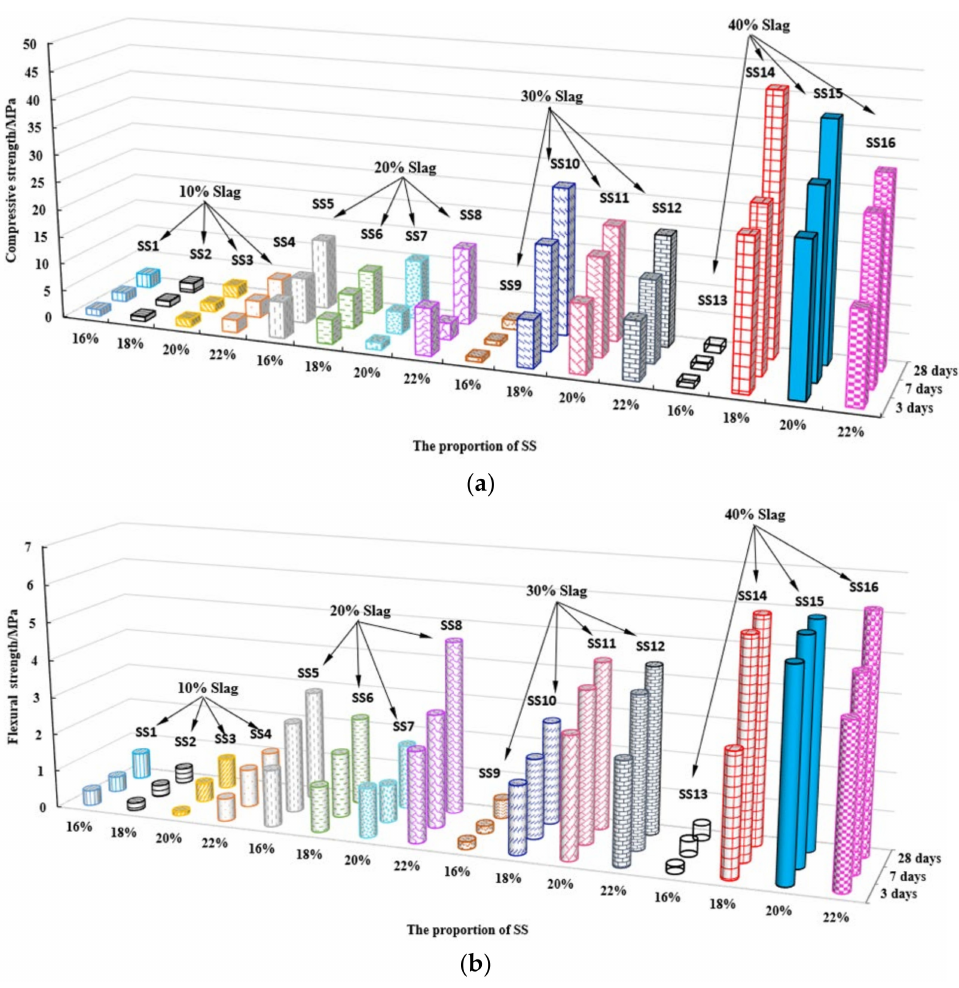
Figure 5. Compressive and flexural diagram of 16 groups of SS activator specimens. ( a ) compressive strength diagram ( b ) flexural strength diagram. Table 6. Range and variance analyses of 3, 7, and 28-day compressive and flexural